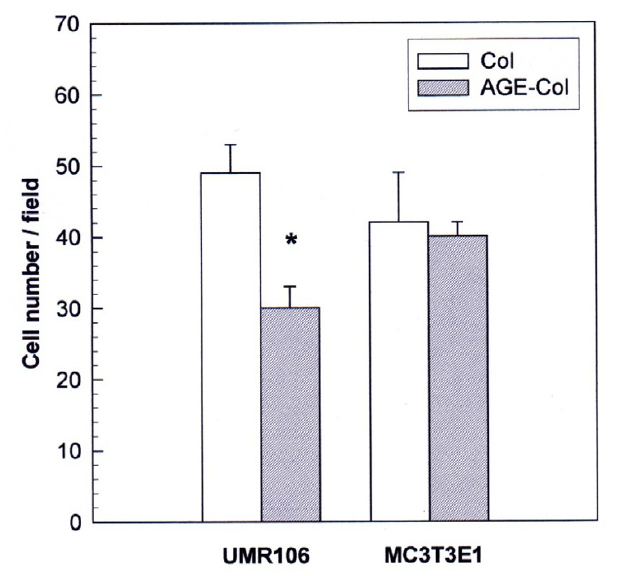
Figure 2 Effect of an AGE-modified type I collagen matrix on UMR106 cell proliferation and spreading. UMR106 osteosarcoma cells were cultured on an unmodified collagen matrix or an AGE- collagen matrix for 24 hours at 37 ° C. Cell proliferation was evaluated by microscopically counting cells stained with Giemsa, at a magnification of 400X. Cellular spreading was also estimated microscopically, as the number of cells pos- sessing at least two comers. Results are given as the number of cells counted per field, and are expressed as the mean ± SEM. Differences between collagen vs. AGE-collagen are as follows: * p <